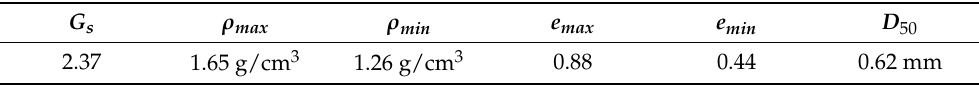
Table 3. Physical properties of calcareous